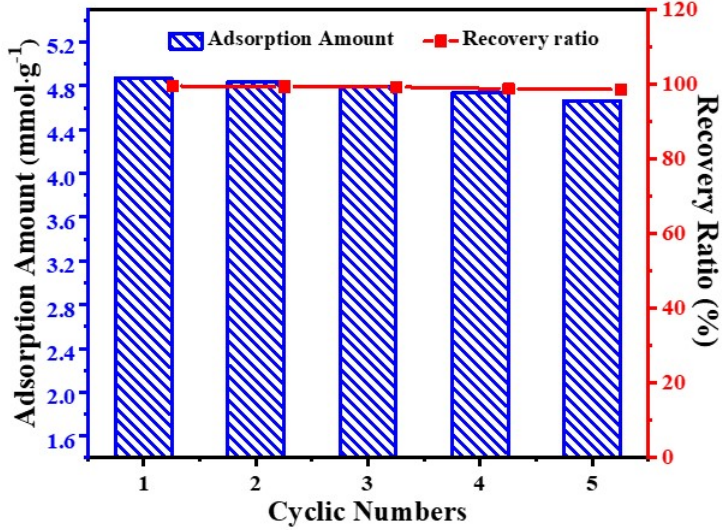
Figure 8. Cycling of CO 2 adsorption by GO(0.25)/MR-500 at 298.15 K and 500 kPa.